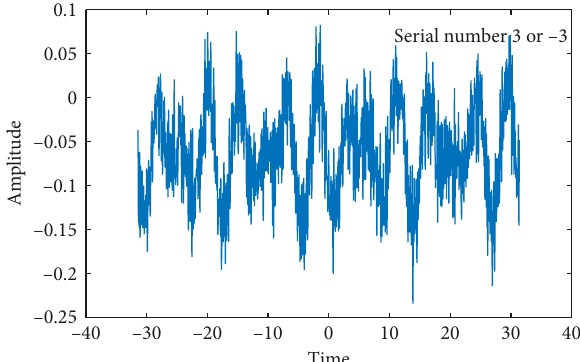
Figure 8: The real part of the serial number 3 or